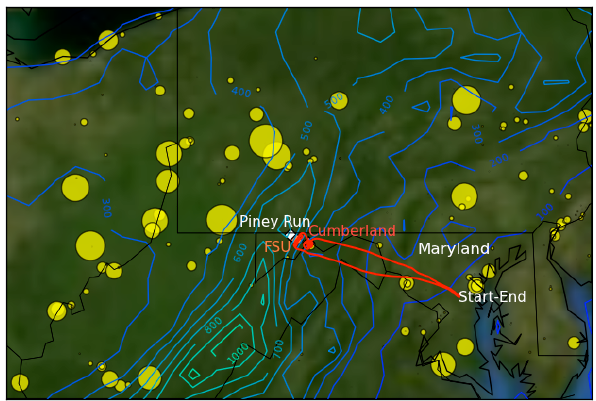
Fig. 9. Monthly averaged concentrations of SO 2 at the surface in 2010 at the Piney Run station. Blue squares are observations, red circles are model simulations with the control run, black circles are revised model simulations. Vertical bars are the standard deviations of monthly values for the model, shaded blue area for